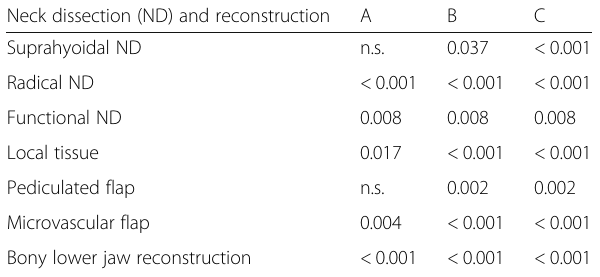
Table 6 Relation between neck dissection/reconstructions and the wish for CRS (A), felt appearance (B) and felt cicatrisation